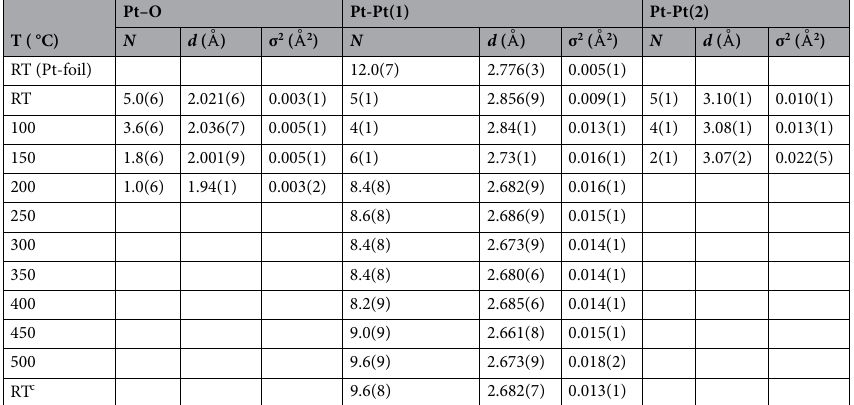
Table 1. Fit results of EXAFS data of Pt/Ti–FS at the Pt L 3 edge. RT c is the room temperature after being heated up to 500 °C and cooled down. Data are shown in Fig. 4a. N is the coordination number, d is the distance, and σ 2 is the Debye–Waller factor of atomic pairs. S 02 = 0.86 was determined by fitting the EXAFS data of a Pt foil and used in the other